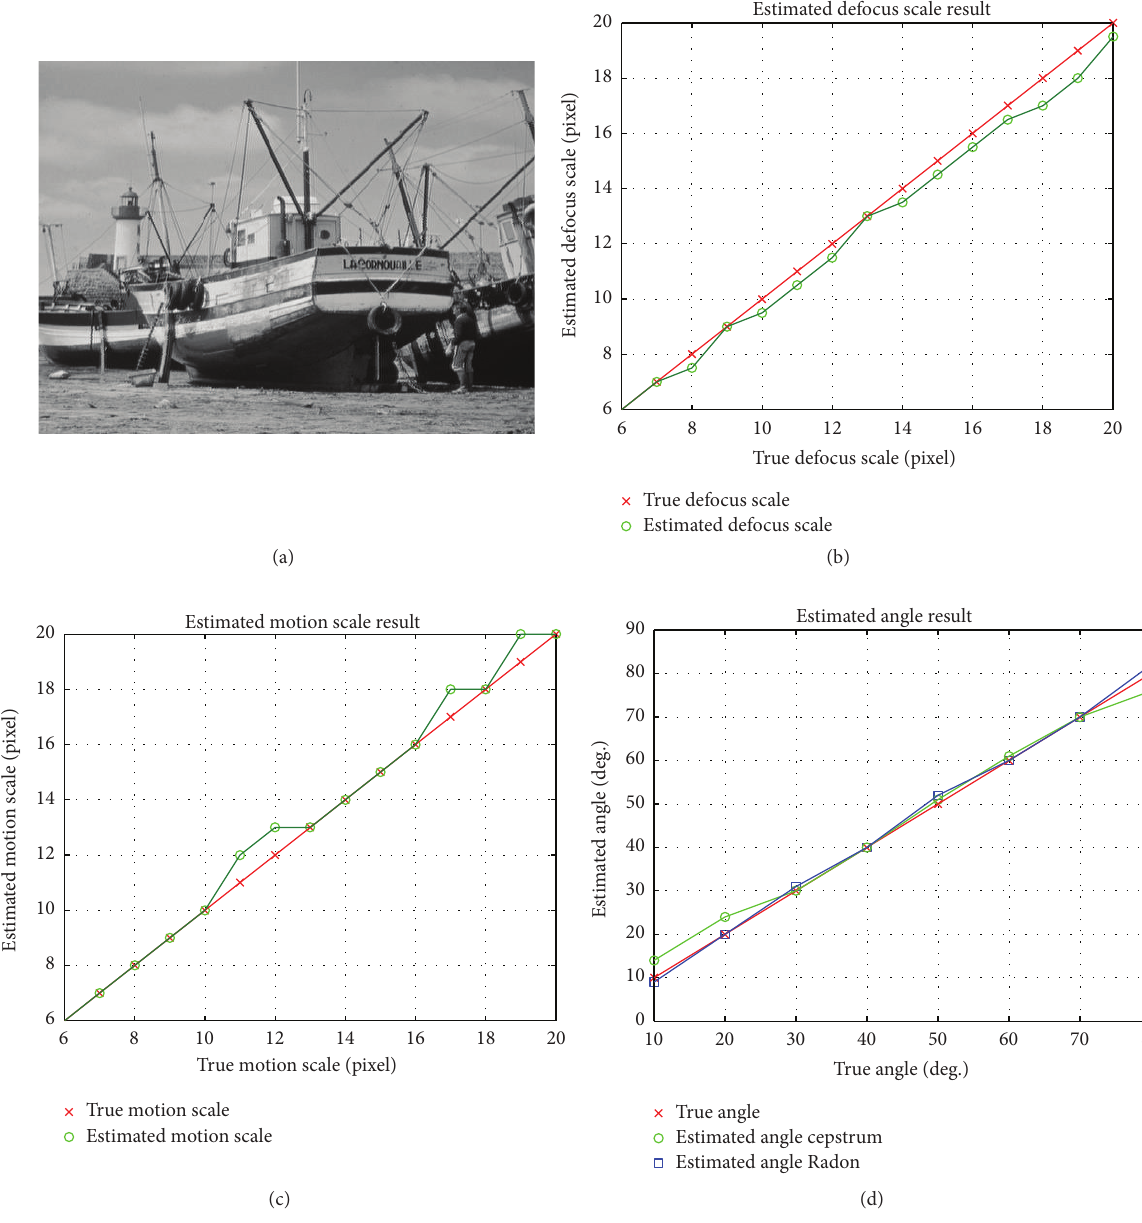
Figure 5: The estimation result of the cepstrum based estimation method. (a) is the original image used to test the cepstrum based blur kernel estimation algorithm. (b) is the defocus blur scale estimation result. The test images are generated using the original clear image and the defocus blur kernels whose scale ranges from 6 to 20. The red line is the defocus blur scale of the test images; the green line is the estimated blur scale using the cepstrum based algorithm. (c) is the result of the motion blur scale estimation results. The test images are generated using the original clear image and the motion blur kernels whose scale ranges from 6 to 20. The angle of the motion blur kernels is set at 30 degrees in order to test the motion blur scale estimation algorithm. The red line is the motion blur scale of the test images; the green line is the estimated motion blur scale. (d) is the motion blur angle estimation results. The test images are generated using the original clear image and motion blur kernels whose angles range from 10 to 80 degrees. The blur scale of the motion blur kernel is set at 8 pixels in order to test the motion blur angle estimation algorithm. The red line is the motion blur angle of the test images, the green line is the motion blur angle estimation algorithm based on cepstrum, and the blue line is the improved estimation algorithm based on Radon